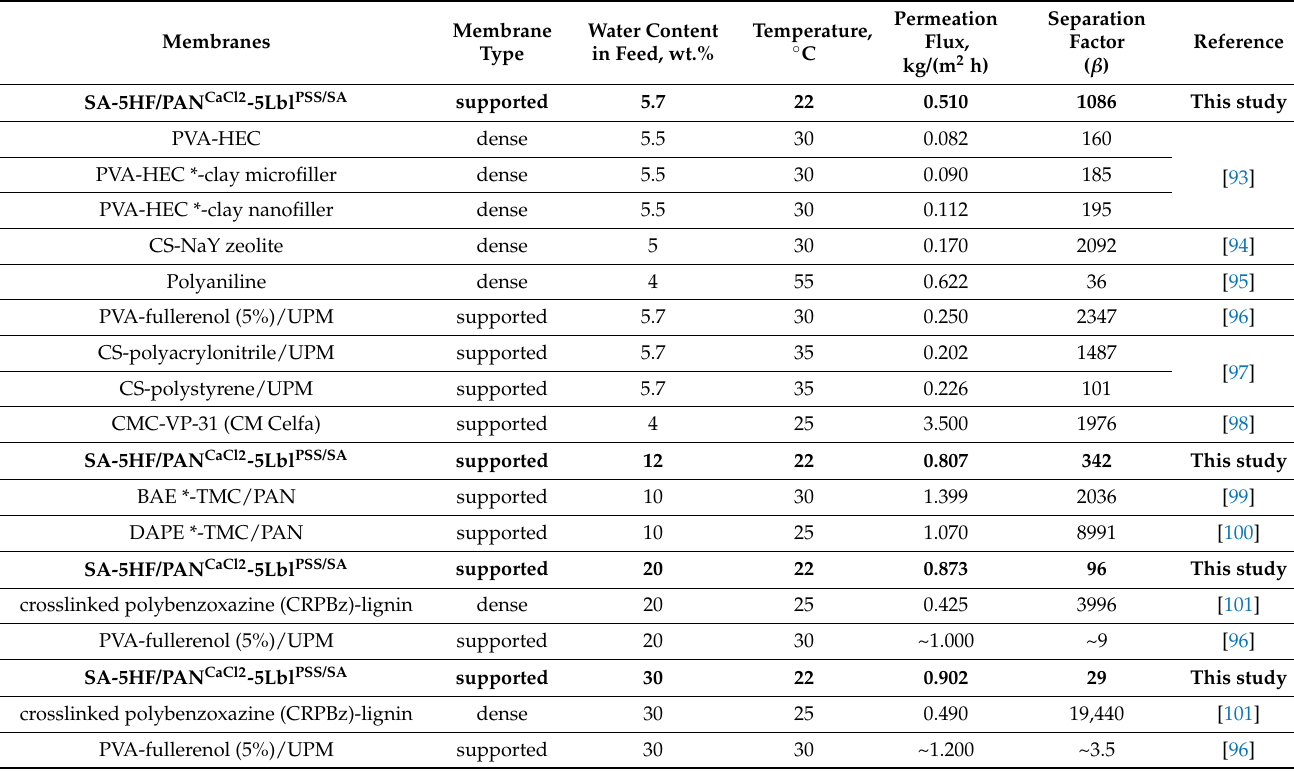
Table 9. Comparison of the transport properties of the membranes in the pervaporation dehydration of THF.